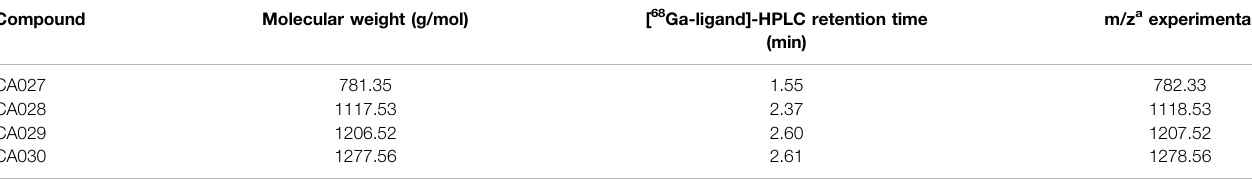
TABLE 1 | Analytic data of the novel ligands. Compound Molecular weight (g/mol)